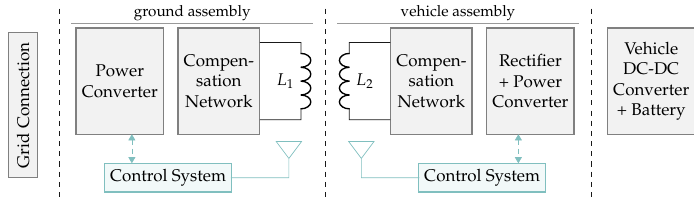
Figure 29. SAEJ2954 block